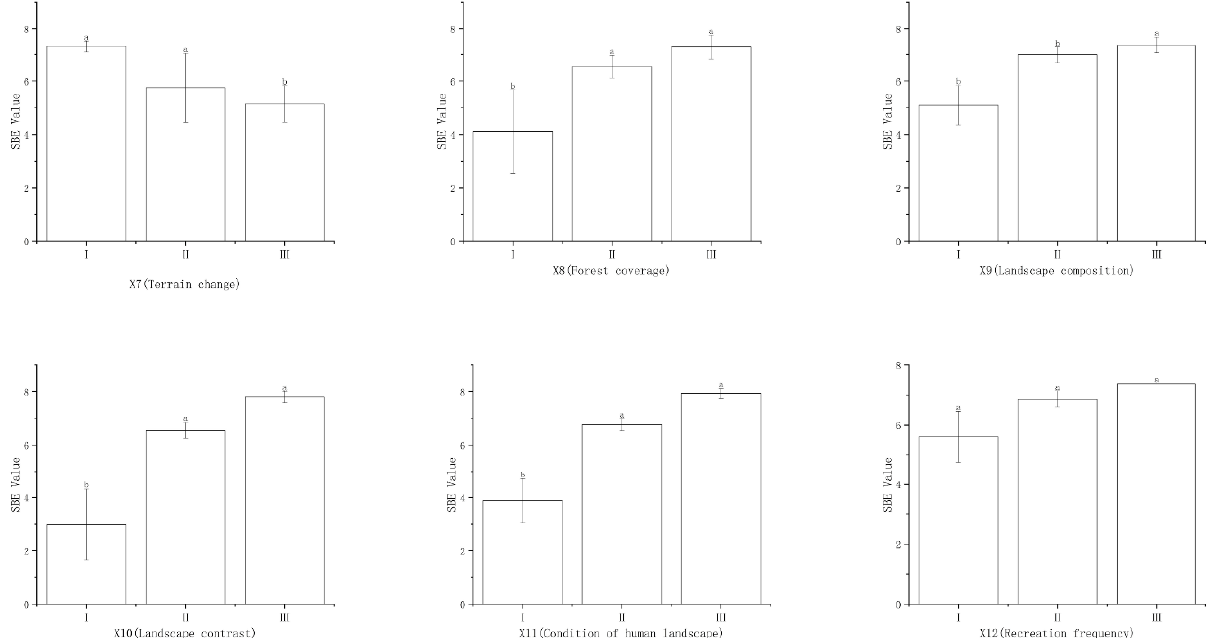
Figure 7. Relationships between landscape elements’ grades and SBE from the aerial perspective. (When a and b or a, b, and c symbols appeared in different landscape element classes, the difference is significant or highly significant; if both are a, the difference is not significant.)